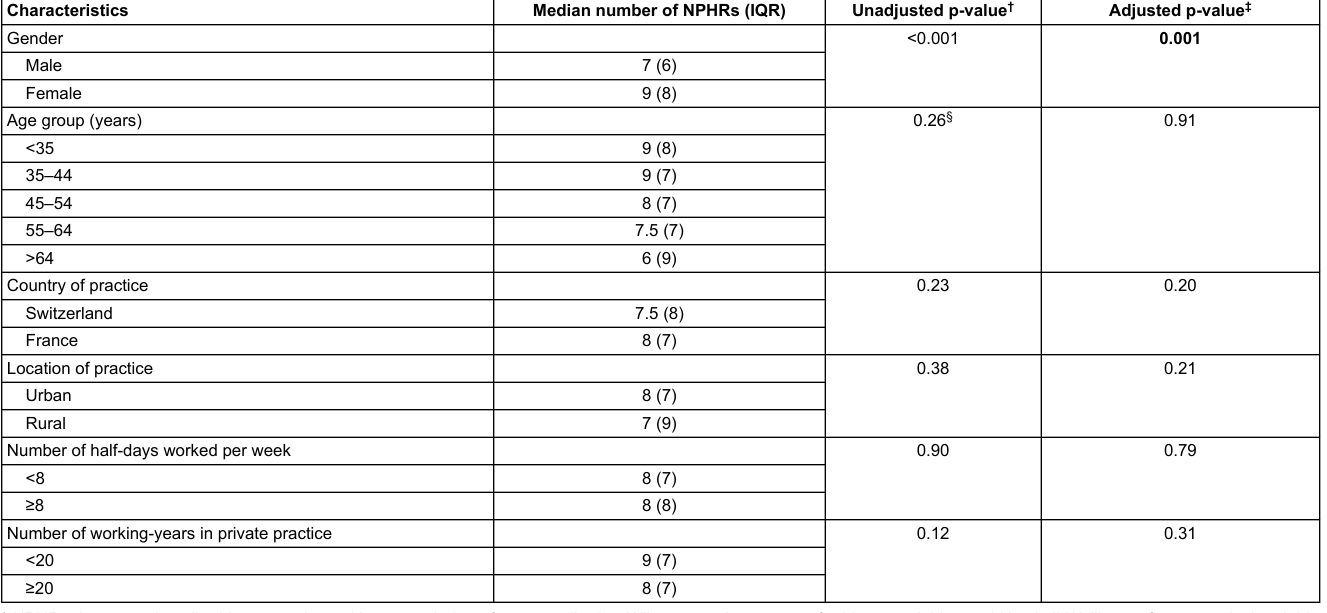
Table 3: Frequently prescribed non-pharmacological home remedies (NPHRs) * , stratified by general practitioners’ sociodemographic characteristics. Characteristics